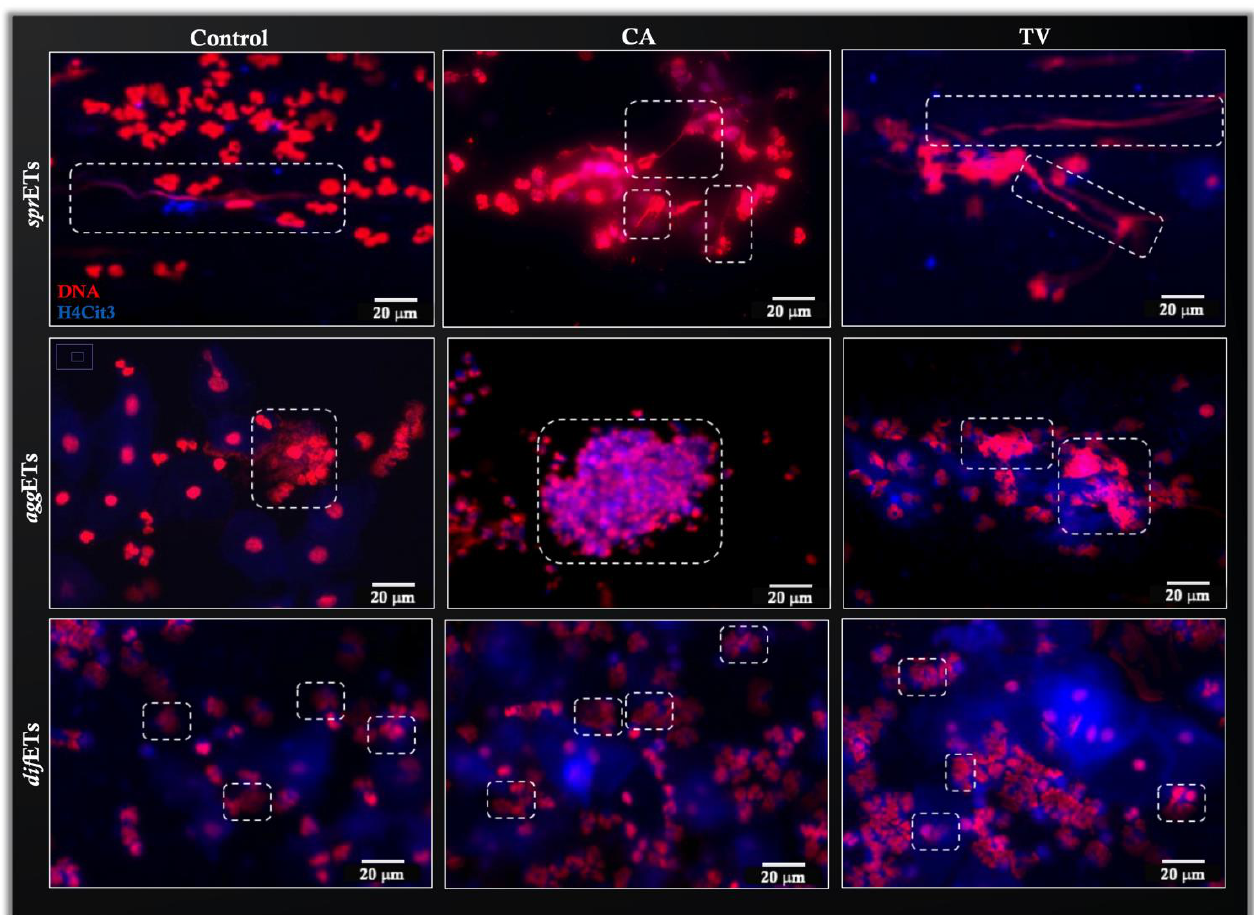
Figure 4. Representative images of CA- and TV-positive vaginal discharges and control (c) presenting NETs in their different morphologies. In all the images, red indicates DNA stained with Sytox Orange and blue indicates stained citrullinated histone (H4Cit3). The outline in white indicates the type of NET that each image represents : spr NETs, “ spread ” ; agg NET, “ aggregated ” ; diff NETs, “ dif- fuse ” .